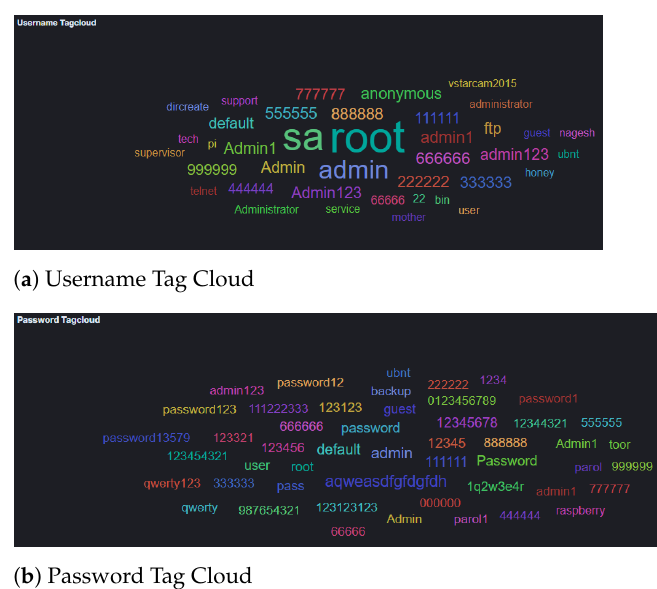
Figure 11. Microsoft Azure Cowrie Username and Password Tag Cloud.